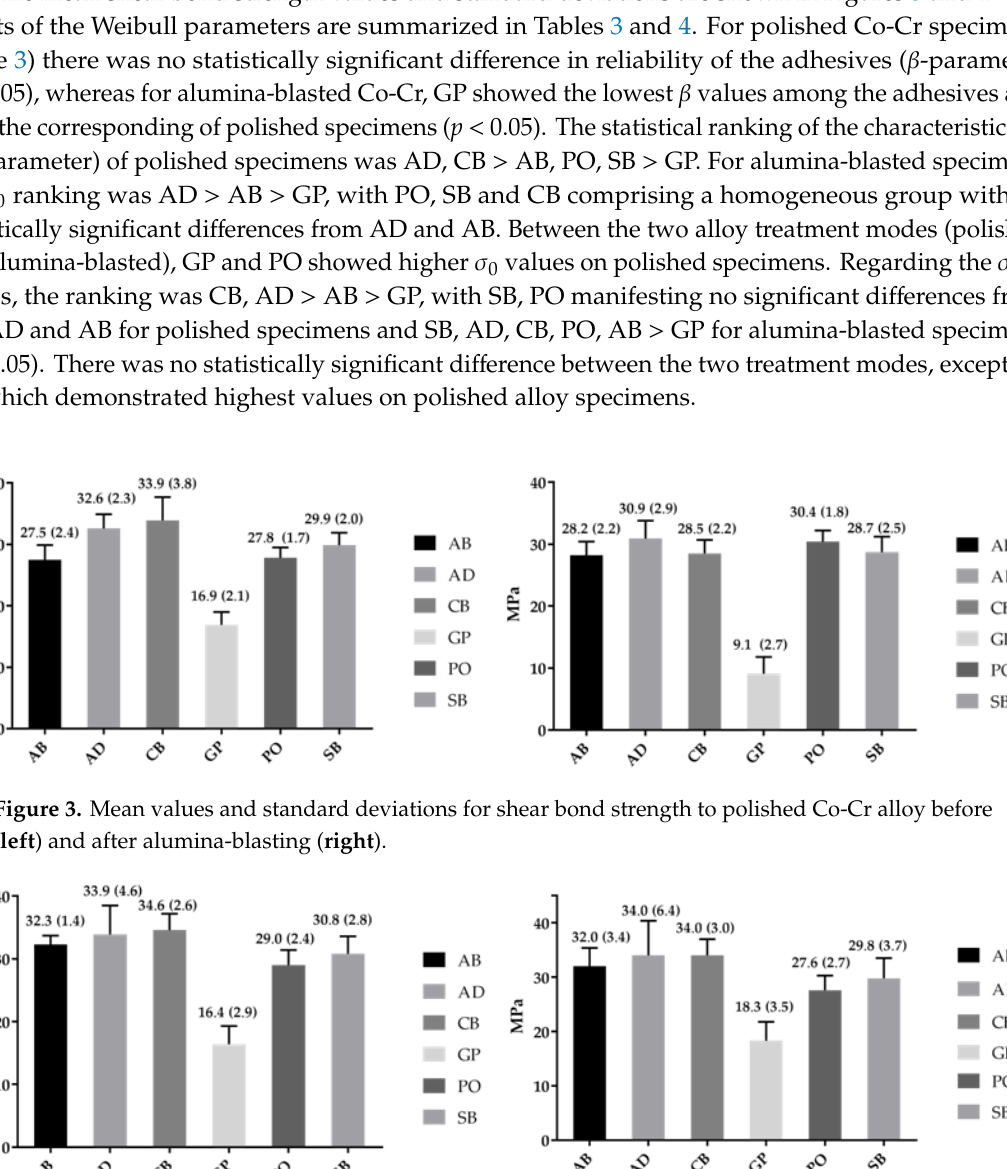
Table 2. The means and standard deviations of the roughness parameters tested. Same superscript letters show values with no statistically significant difference within each treatment group per parameter ( t -test, p > 0.05). Asterisks denote the Co-Cr (*) and 3Y-TZP (**) pairs where non-parametric analysis was performed (Mann – Whitney test).